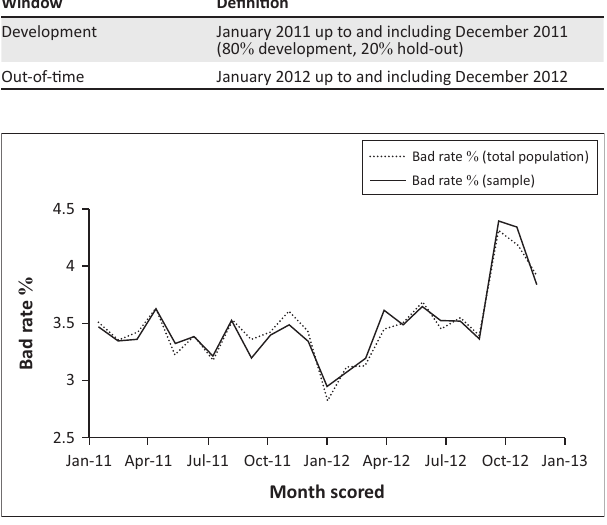
FIGURE 5: Accepted clients’ bad rate ( % ).